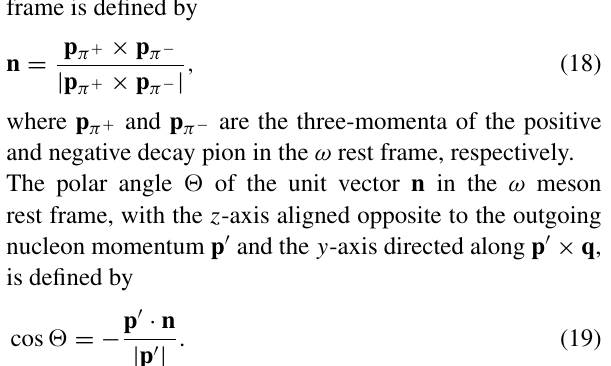
Fig. 1 Definition of angles in the process μ N → μ N ω with ω → π + π − π 0 . Here, (cid:11) is the angle between the ω production plane and the lepton scattering plane in the centre-of-mass system of the virtual photon and the target nucleon. The variables (cid:13) and φ are respectively the polar and azimuthal angles of the unit vector normal to the decay plane in the ω meson rest